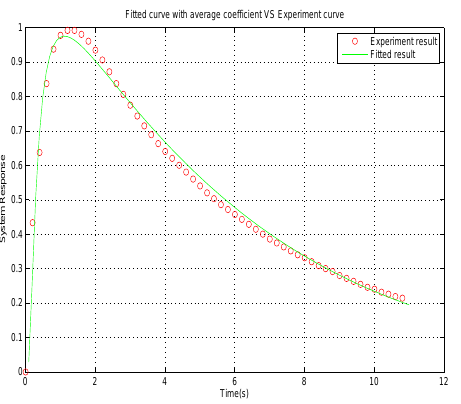
Figure 8. The (cid:12)tting circle vs the experiment